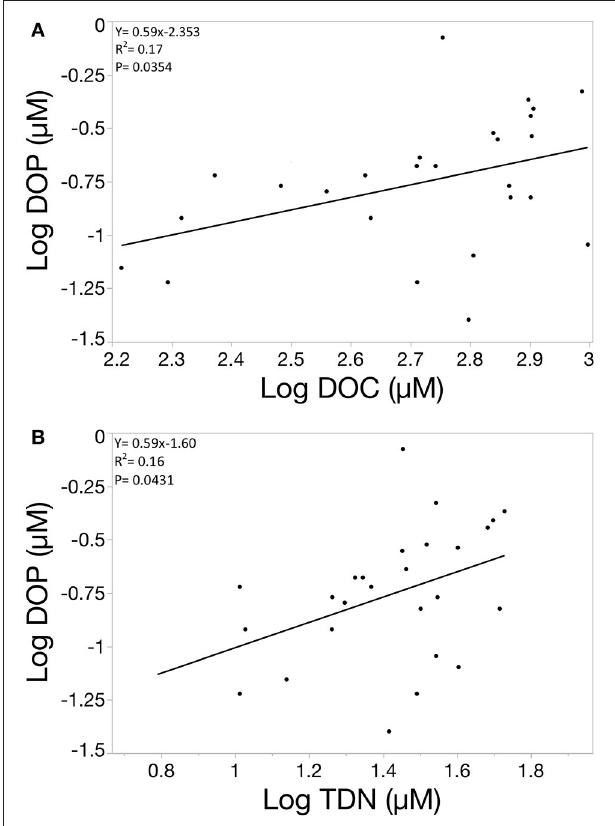
FIGURE 2 | Scatterplots showing the relationship between DOP and DOC (A) and between DOP and TDN (B) . All values are log transformed. DOP shows a significant positive correlation to both DOC and TDN, but the relationship is weak in both cases with R 2 values below 0.2 for both